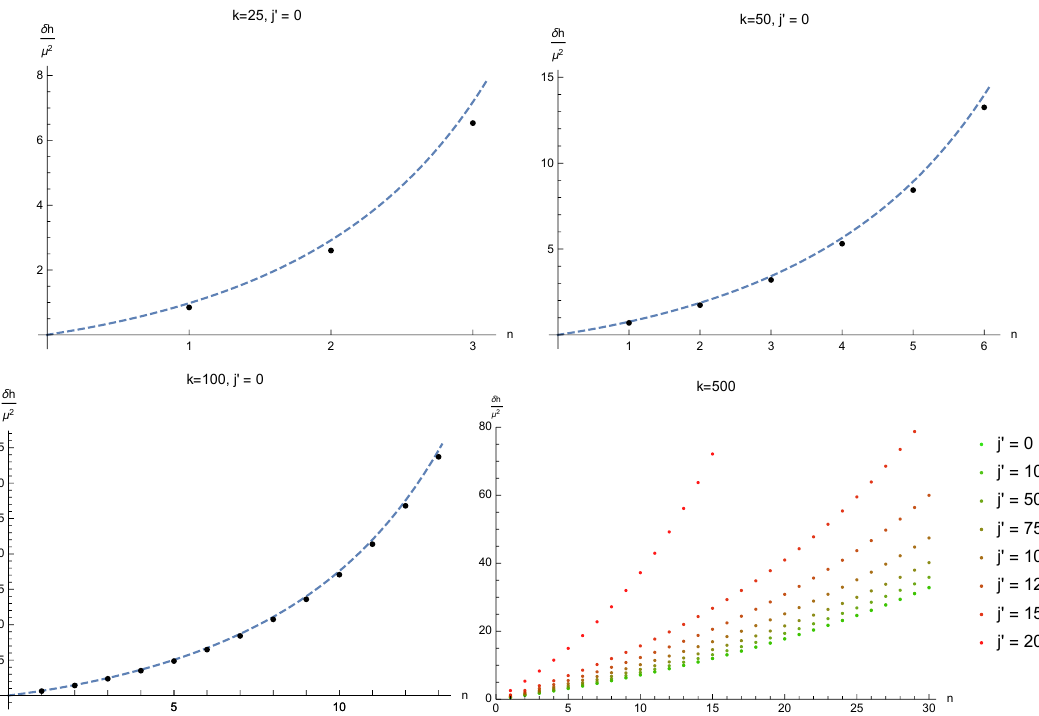
Figure 1 . The leading anomalous weight δh in units of µ 2 as a function of the oscillator number n (with h int = 0 ). In the first three plots, the blue dashed curve represents the anomalous weight inferred from the semiclassical quantization of the pulsating string solution (4.27), while the black dots denote the quantum result. In the bottom-right plot, we have plotted the quantum anomalous weights (colored dots) for various S 3 angular momentum quantum numbers j 0